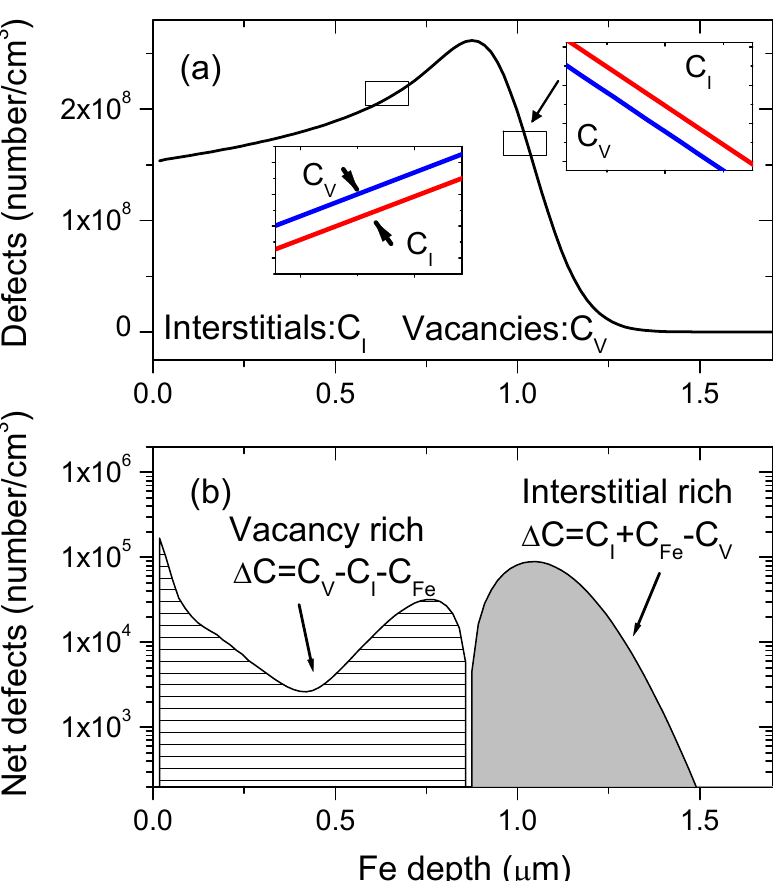
Figure 1. ( a ) Initially created interstitial and vacancy distributions in Fe irradiated by one 3.5 MeV Fe atom, and ( b ) defect imbalance (excessive vacancy and excessive interstitial) at different regions, calculated by using the Boltzmann Transport Equation method. Figures are modified from Reference [10].